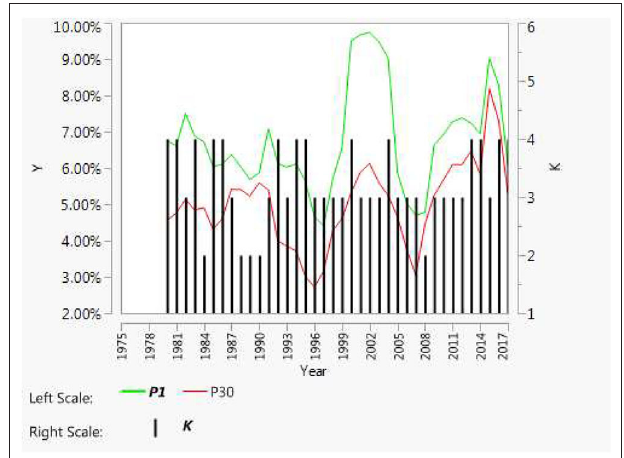
FIGURE 1 | Optimum number of factors and standard deviation of portfolio 1 &